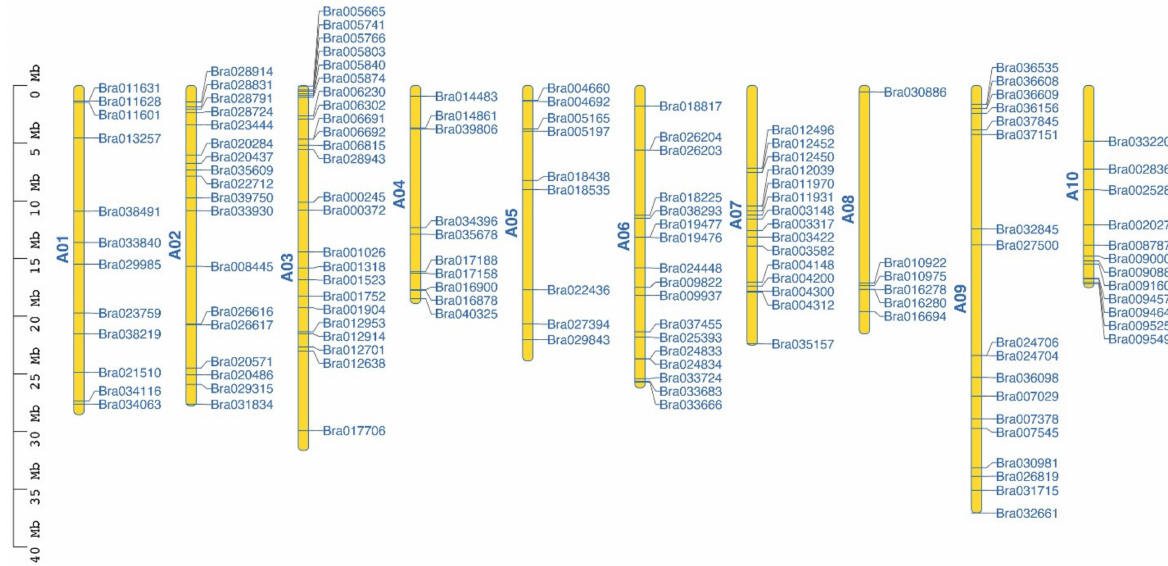
Figure 1. Chromosome distribution of C2H2 ZFP family members in B. rapa . The 141 members are distributed over 10